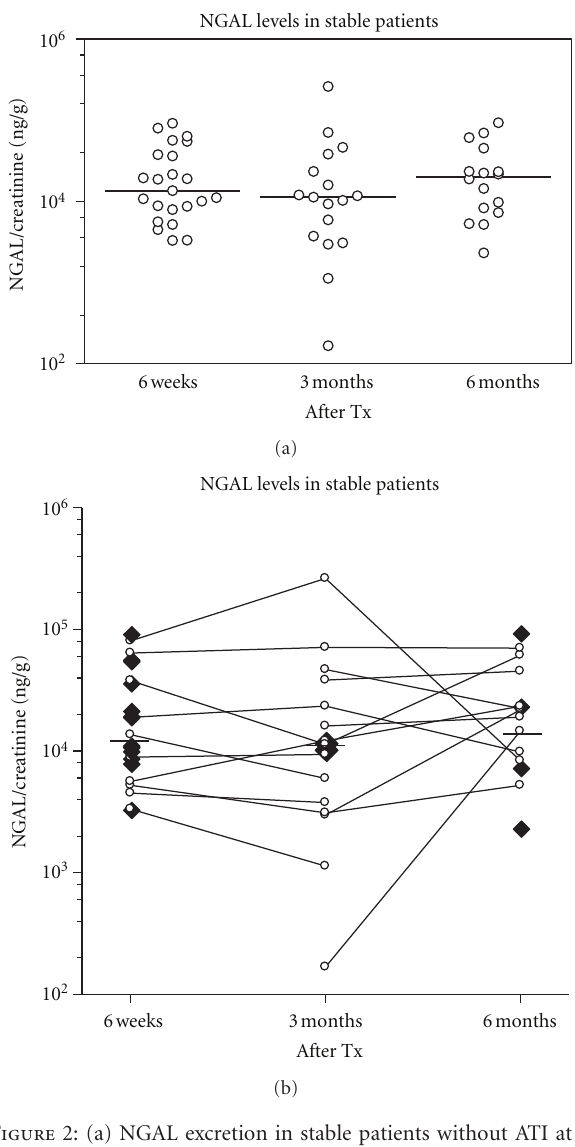
Figure 2: (a) NGAL excretion in stable patients without ATI at 6 weeks, 3 months, and 6 months after transplantation. Shown is the urinary NGAL/creatinine ratio at 6 weeks ( n = 23), 3 months ( n = 17), and 6 months ( n = 16) in patients after kidney transplantation. (b) Individual course of NGAL excretion of the stable patients at 6 weeks, 3 months, and 6 months after transplantation. Depicted are single measurements ( n = 13 at 6 weeks, n = 2 at 3 months, n = 4 at 6 months) as single black squares and serial measurements (6 weeks to 3 months: n = 4 patients, 3 months to 6 months: n = 5 patients, and 6 weeks to 3 months and 6 months: n = 6 patients) as open circles connected by lines. Total measurements at 6 weeks: n = 23, at 3 months: n = 17, and 6 months: n = 16.